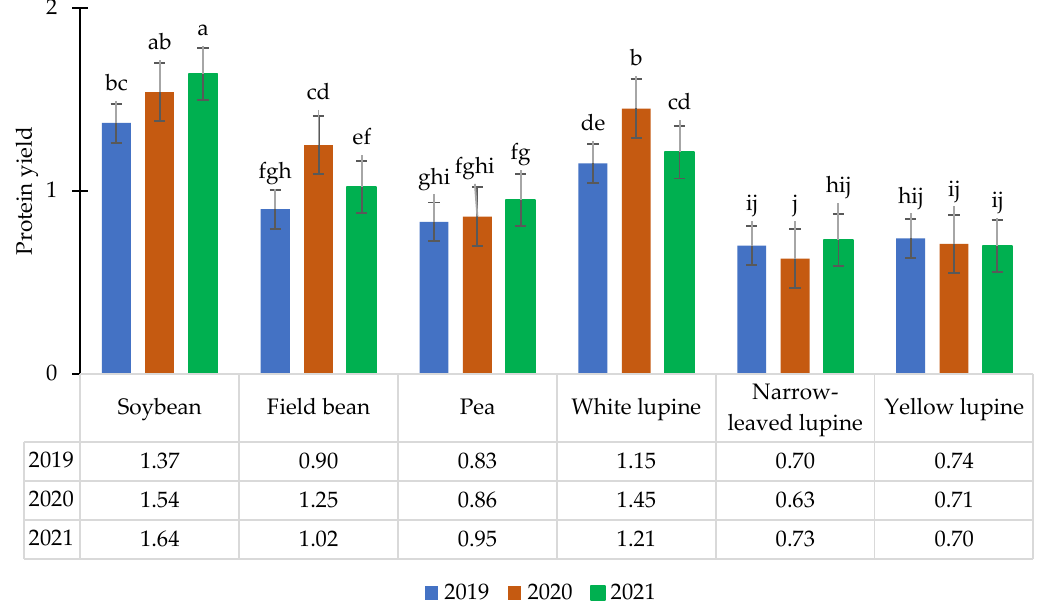
Figure 3. Total protein yield in t ha −1 . Different lowercase letters indicate significant differences ( p < 0.05) according to the analysis of variance (ANOVA). The standard error is marked on the bars. Popović et al. [10] showed that soybean protein yield depended on the cultivar and years of study and averaged 1.9 t ha −1 . Jarecki [43] and Jarecki and Borecka-Jamro [44] reported that soybean protein yield varied from 1.25 to 1.46 t ha −1 , depending on the years of study. Fordoński et al. [38] demonstrated that the protein yield of faba bean was high, averaging 1.6 t ha −1 . Csajbók et al. [45,46] noted that the protein and oil contents of soybean varieties are mainly genetically regulated. The protein yield depends more on the seed yield than the protein content.